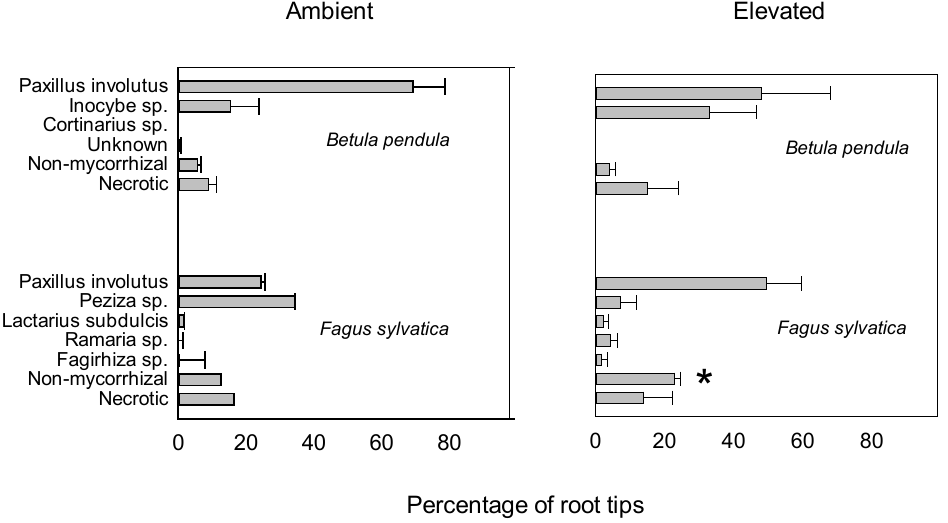
Figure 4. Percentage of colonisation of different mycorrhizal fungi on roots of Betula pendula and Fagus sylvatica at BangorFACE grown under ambient or elevated CO 2 levels (FACE). Bars show the mean and SE. * Statistically significant ( p ≤